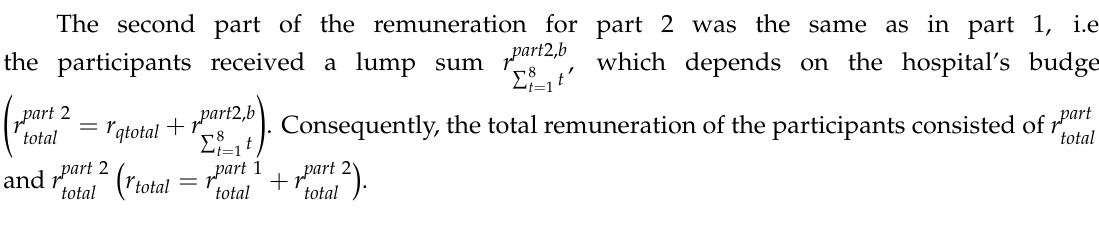
Table A7. Experimental Parameters and